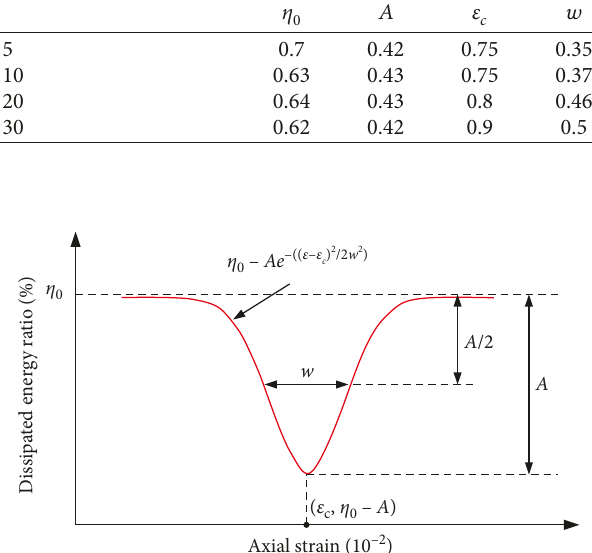
Figure 12: Meaning of the function image and the parameters of the DE proportion.